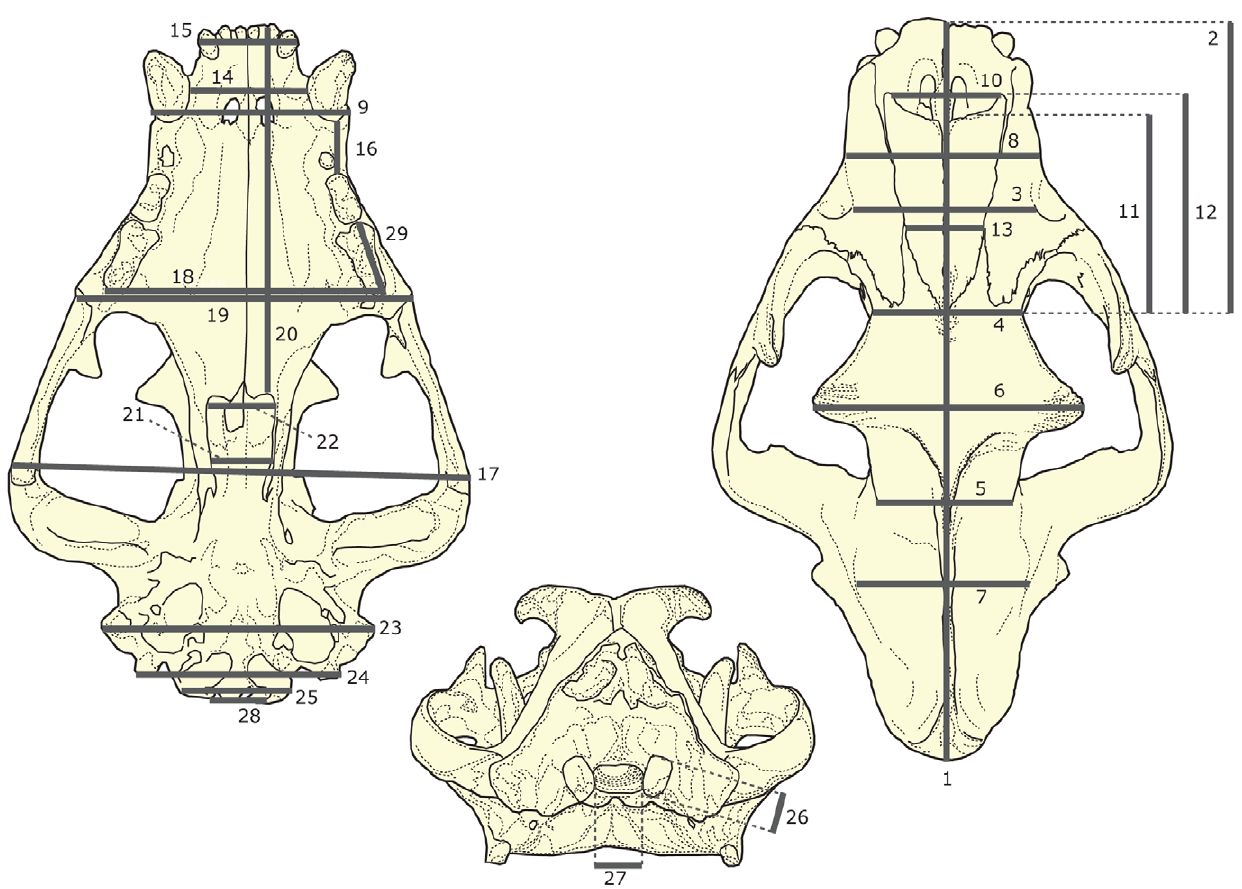
Figure 3. Description of cranial measurements. A skull of a lion is shown with diagrammatic representations of the 29 cranial measurements used in the morphometric analyses. The actual measurements are Euclidean distances between two points on the skull specimen and are not two- dimensional projections as depicted here. 1, L SkT : total skull length (distance between inion and prosthion). 2, L Face : face length (distance between prosthion and naso-frontal suture). 3, W iof : distance between infraorbital foramina. 4, W o : distance between orbits. 5, W POC : width across postorbital constriction. 6, W POP : width across postorbital processes. 7, W BC : maximum braincase width (greatest distance between lateral margins of braincase). 8, W sn : snout width (measured at level of snout mid-length). 9, W C1s : width across the snout (measured between bases of upper canines [C1s]). 10, W NA : nasal aperture width (measured at rostral projection of nasals). 11, L N : nasal length (measured parasagittally between naso-frontal suture and dorsal margin of external narial opening). 12, L NT : total nasal length (measured parasagittally as the distance between the naso-frontal suture and the anteriormost tip of the nasal). 13, W MFS : width across the nasals (measured between the left and right maxillo-frontal sutures [MFS]). 14, W IC1s : inter- canine width (measured between the upper canines). 15, W I3s-I3s : width across the incisor arcade (measured between left and right third upper incisors [I3s]). 16, L C1sP3s : length of upper ‘diastema’ (measured as the distance between C1s and upper third premolars [P3s]); although species that possess upper second premolars (P2s) do not show a diastema, we regarded their L C1sP3s as the topological equivalent of the mandibular diastema. 17, W Sk : maximum skull width across zygomatic arches. 18, W P4s-P4s : palate width (measured between labial surfaces of upper fourth premolars [P4s]). 19, W Pal : palate width (measured posterior to P4s and between lateral surfaces of maxillae). 20, L Pal : palate length (measured parasagittally as the distance between the prosthion and the posterior extremity of the palatal surface). 21, W PN : internal width of postnarial opening (measured as the distance between left and right pterygoid flanges). 22, W PN.ant : internal width of anterior postnarial opening (measured immediately posterior to palate). 23, W MP : width across mastoid processes. 24, W PocP : width across paroccipital processes. 25, W OC : occipital condyle width. 26, H OC : occipital condyle height. 27, W FM : internal width (transverse diameter) of foramen magnum. 28, W FMV : ventral width of foramen magnum (distance between left and right occipital condyles). 29, L P4s : length of superior fourth premolar or